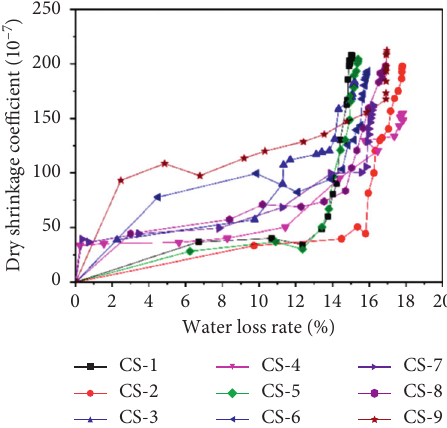
Figure 6: Relationship between dry shrinkage coefficient and water loss rate.